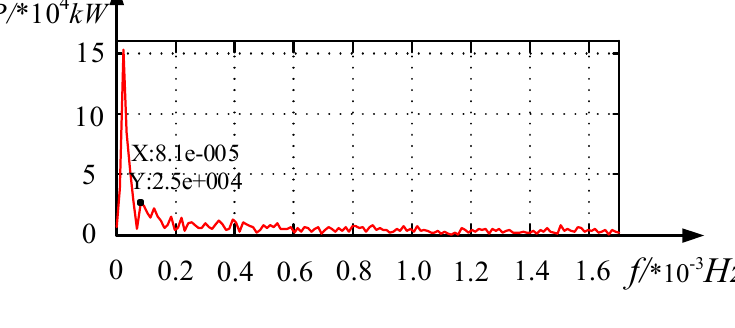
Figure 5. Spectral analysis of P *